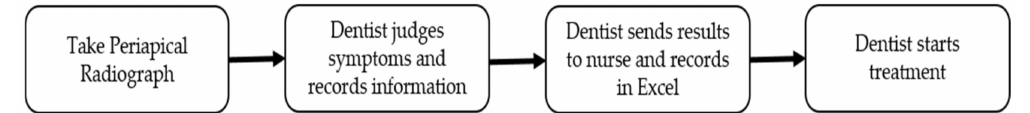
Figure 8. The original flow chart of clinical medicine.